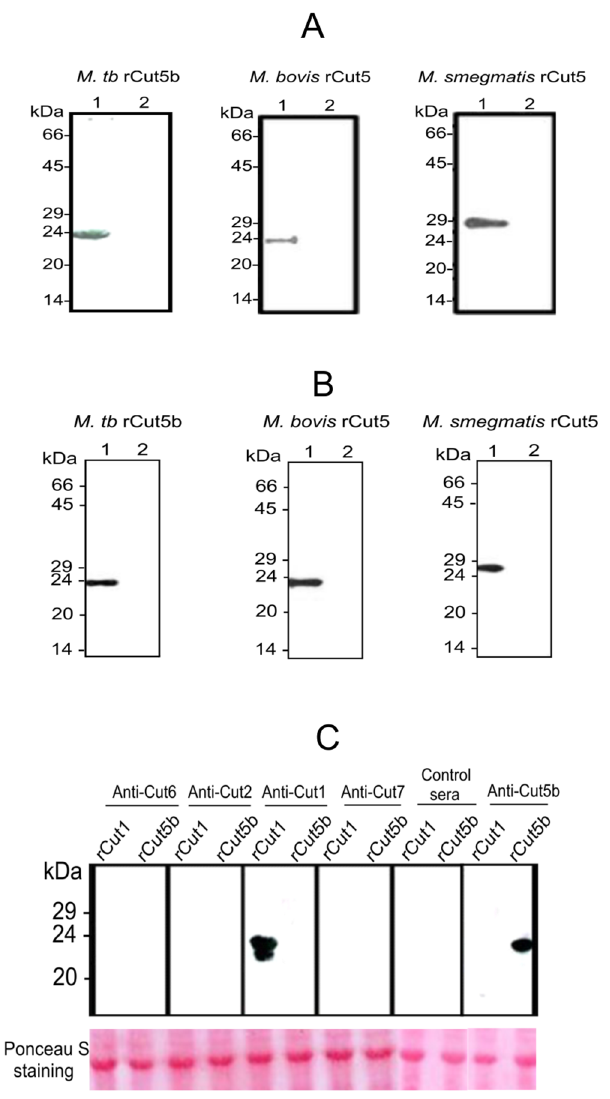
Fig 4. Specificity of Cut5 homologs in